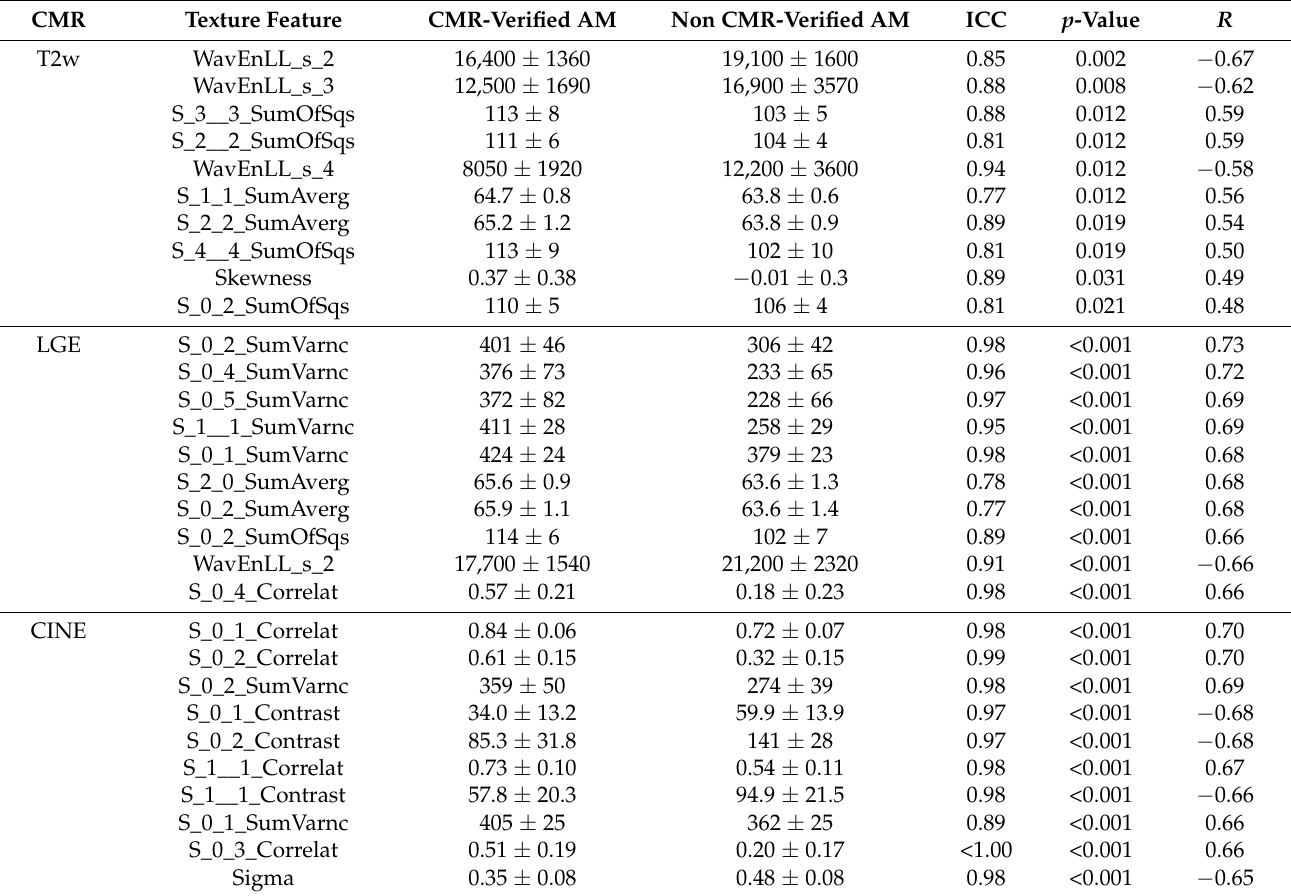
Table 3. Calculated means and standard deviations of ten robust and significant texture features with the highest correlation with AM, extracted from the T2-weighted, LGE, and CINE images. Corresponding ICC-values for reproducibility, p -values for comparisons between groups, and R - values for the association with diagnostic outcome are also presented.